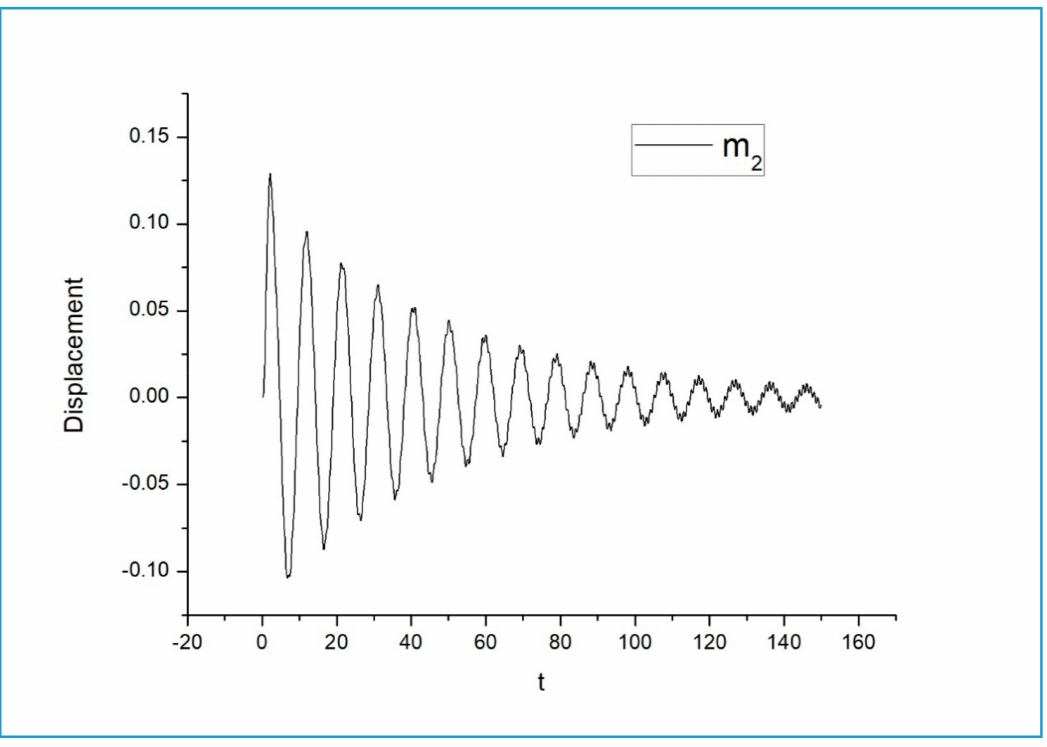
Figure 16. Displacement for m 2 .